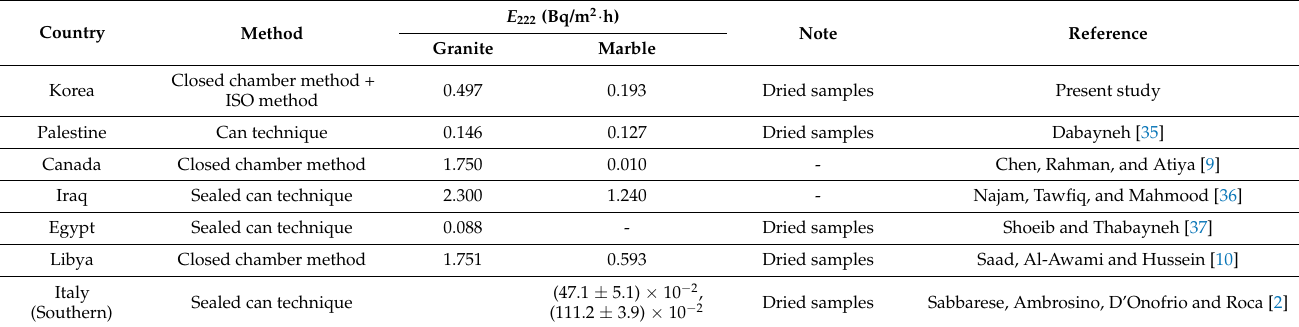
Table 2. 222 Rn exhalation rates from building materials in different